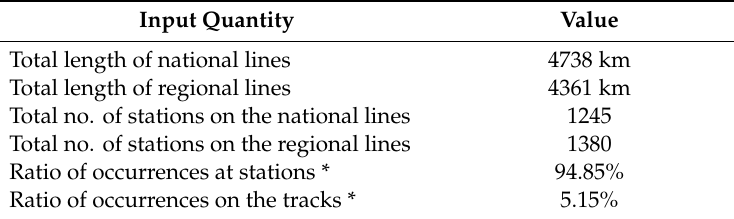
Table 5. Overview of the input data for the final